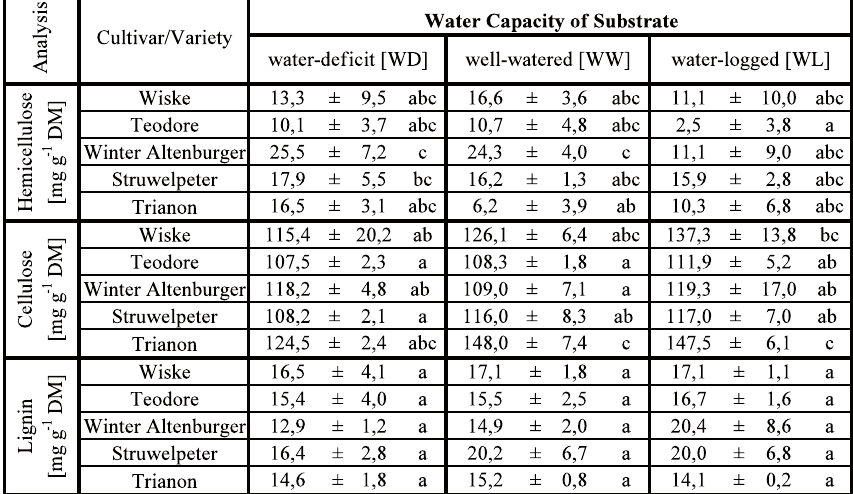
Tab. 3: Hemicellulose, cellulose, lignin [mg g -1 DM] of different cultivars and varieties of Lactuca sativa spp. grown under different water regimes (water- deficit = 18-25 % [WD], well-watered = 50 % [WW], water-logged = 61-70 % [WL]). Data represent n ± SD. Column and rows with different letters were significantly different (Dunett’s T3 test, p ≤